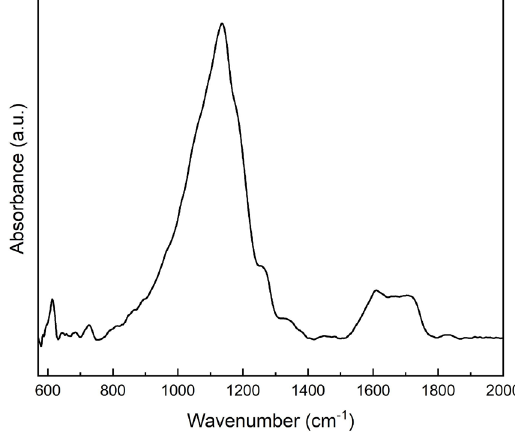
Figure 6. FTIR absorption of a fluorocarbon coating deposited on Si